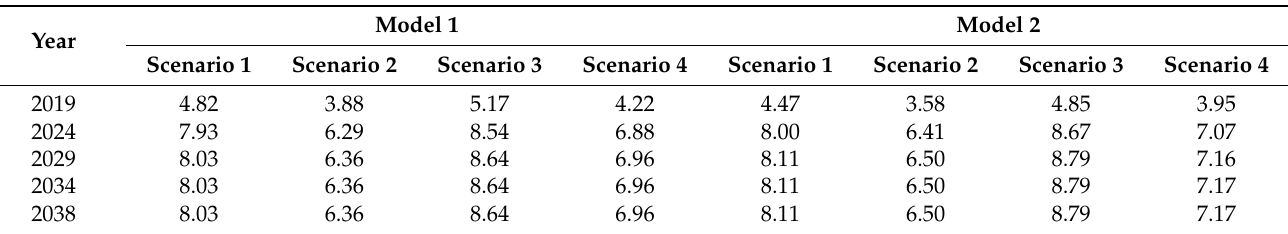
Table 4. Sensitivity analysis: % changes in forecast total energy demand under different alternative scenarios compared to actual